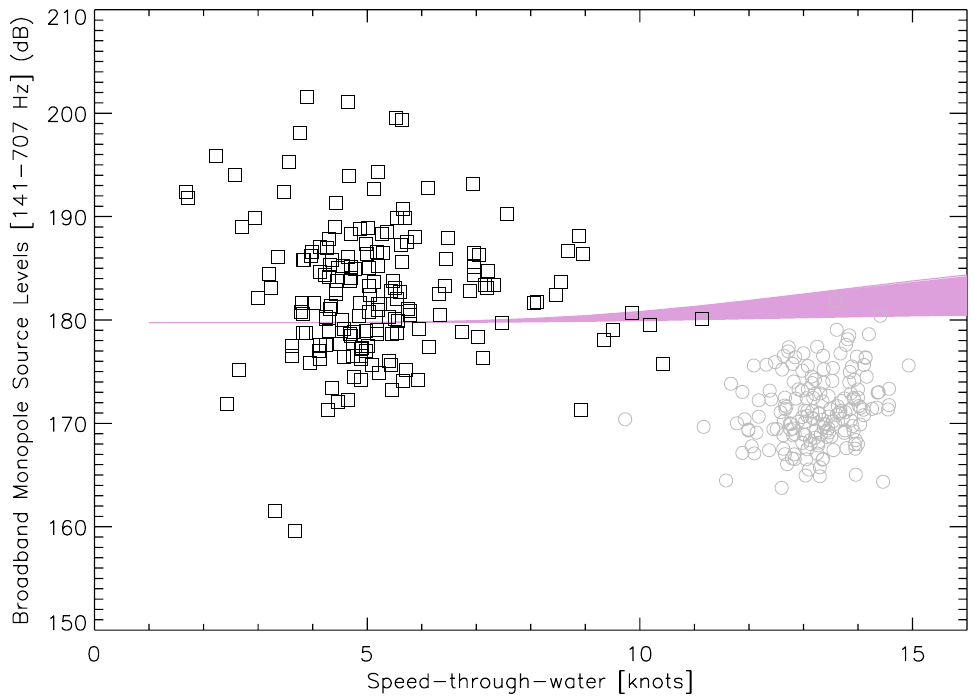
Figure 4. Speed-through-water (STW CPA , STW acc ) vs. broadband source levels ( BB CPA MSL [ f 0 − f 1 ], BB acc MSL [ f 0 − f 1 ] ) according to Table 5. Gray and black data respectively correspond to measurements at t CPA and t acc . Broadband monopole source levels integrated between f 0 and f 1 as predicted by 36 for merchant ships are provided in purple. The model’s space parameters used here include ship’s length (150–250 m), width (28–44 m), draught (6–14 m), engine’s mass (50–250 t.), and number of engines in operation at the same time